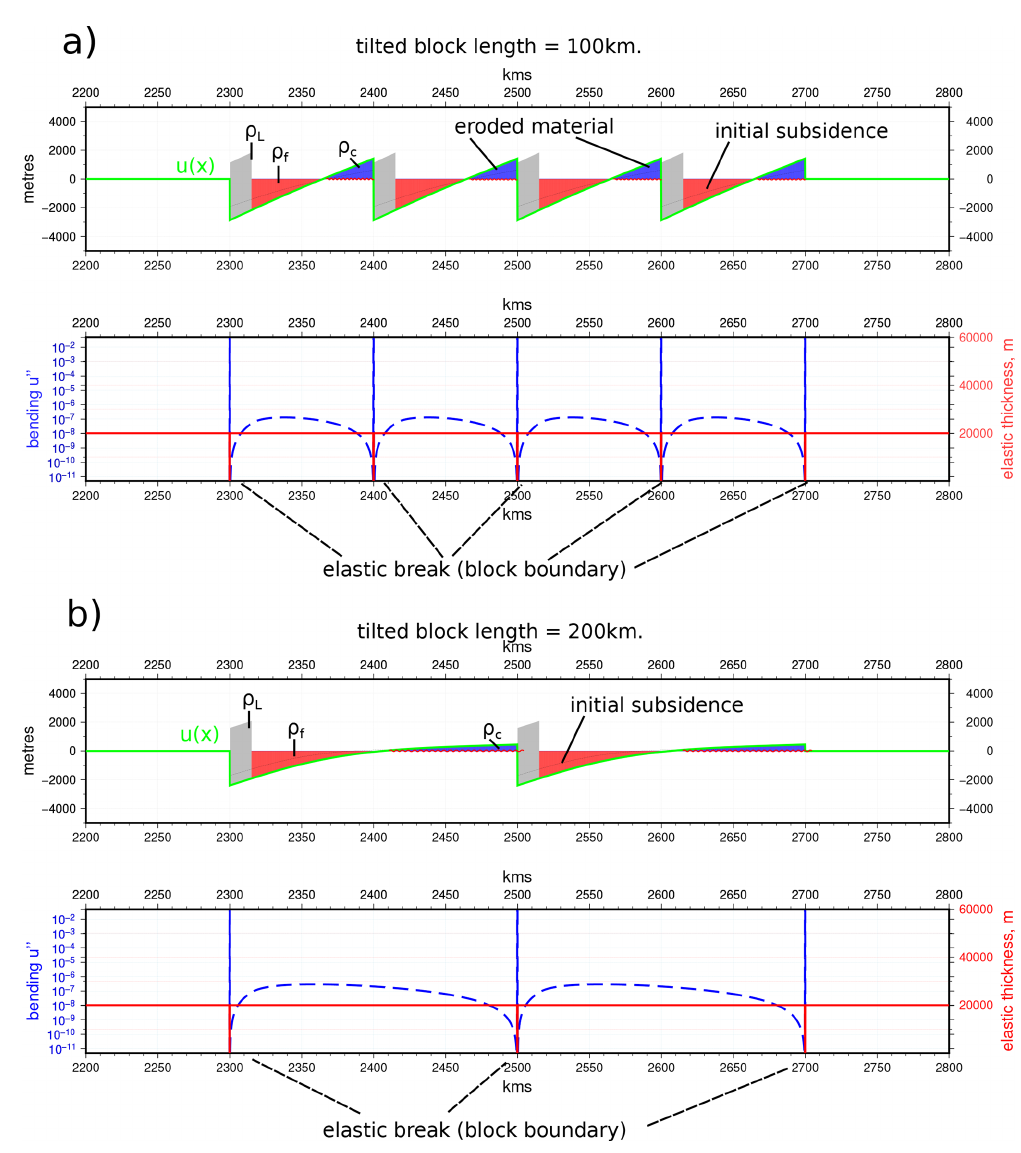
Figure 7. Tilted block model directly equivalent to the force balance model of McQueen and Beaumont (1989) but also incorporating flexure. Calculations assume that basins are filled with infill material (red shading) and the plate surface is eroded to zero topography, removing material (blue shading). For parameters used, see Table A1. (a) 100km block length. Blocks are visually close to rigid and tilted (b) 200km blocks with identical loading, which undergo substantial bending ( ∼ 5 times that of the 100km block). Elastic bending increases as the plate is more strongly held down by the greater length over which mantle resistance forces can act. It is important to note, however, that the plate segments have unconstrained boundaries and are held in place only by their interaction with the mantle. Figure prepared using GMT v6.0.0 (Wessel et al.,